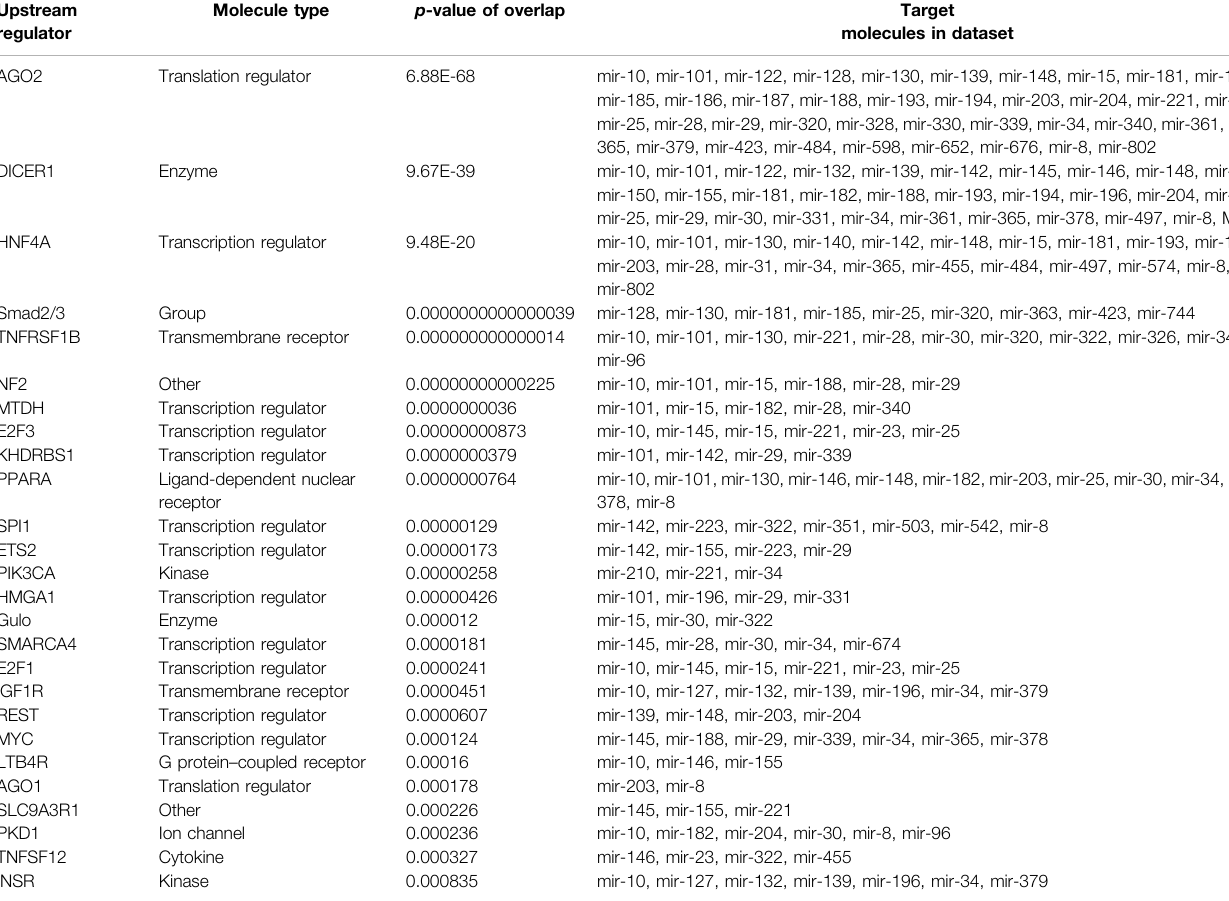
TABLE 3 | Top upstream regulator predicted molecules for the 99 miRNAs signi fi cantly upregulated in the kidney cortex of BTBR mice. Upstream